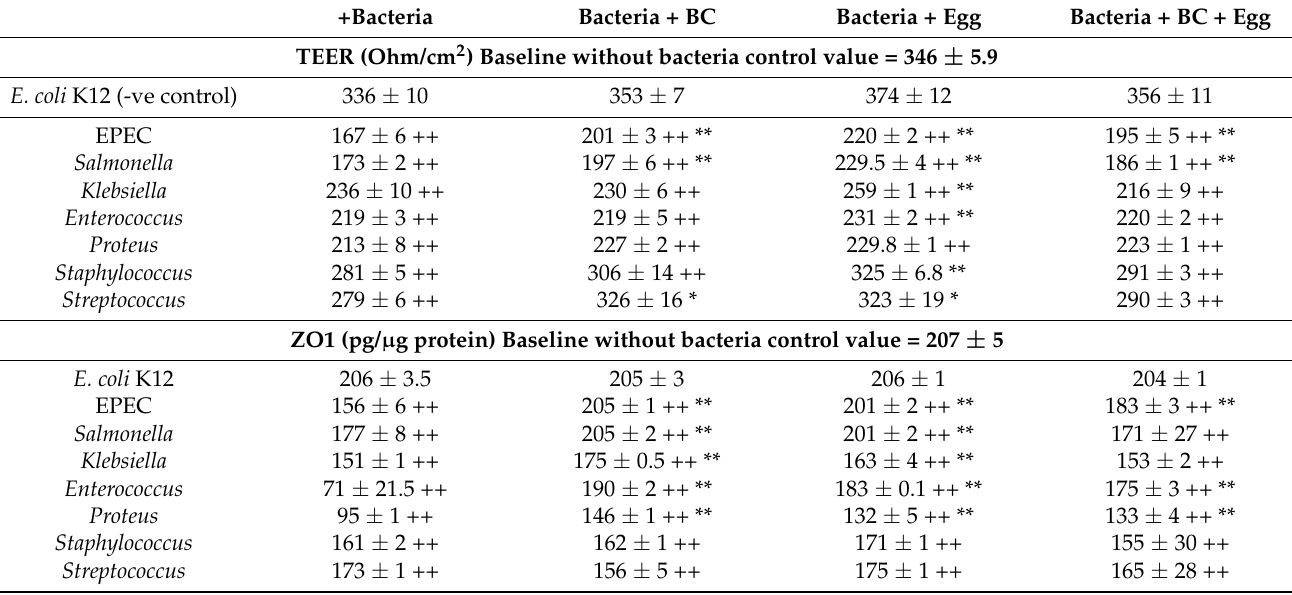
Table 1. Effects of BC alone, egg, or the combination on bacteria-induced changes in TEER and tight junction protein ZO1. +Bacteria Bacteria + BC Bacteria + Egg Bacteria + BC +